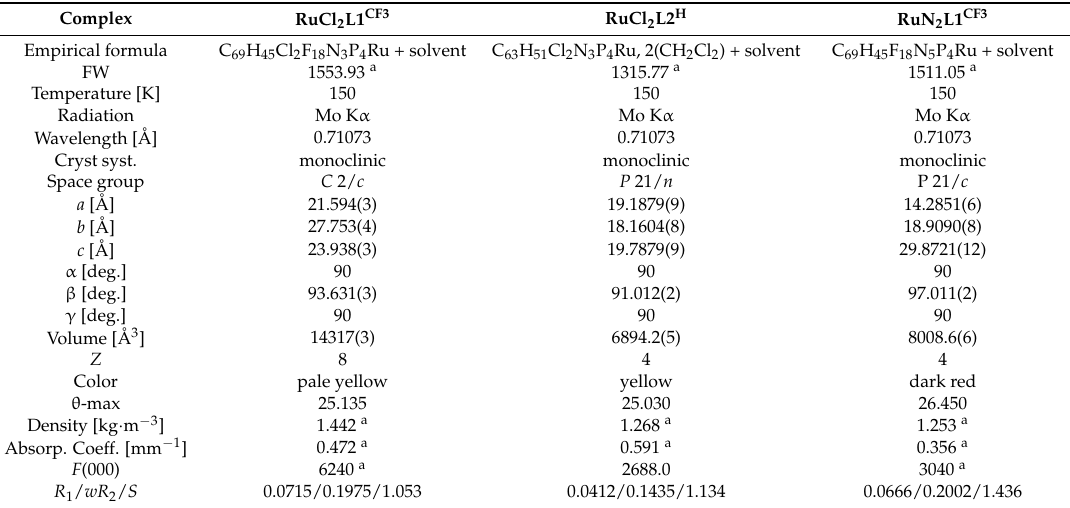
Table 6. Crystallographic data for RuCl 2 L1 CF3 , RuCl 2 L2 H and RuN 2 L1 H . Complex RuCl 2 L1 CF3 RuCl 2 L2 H Empirical